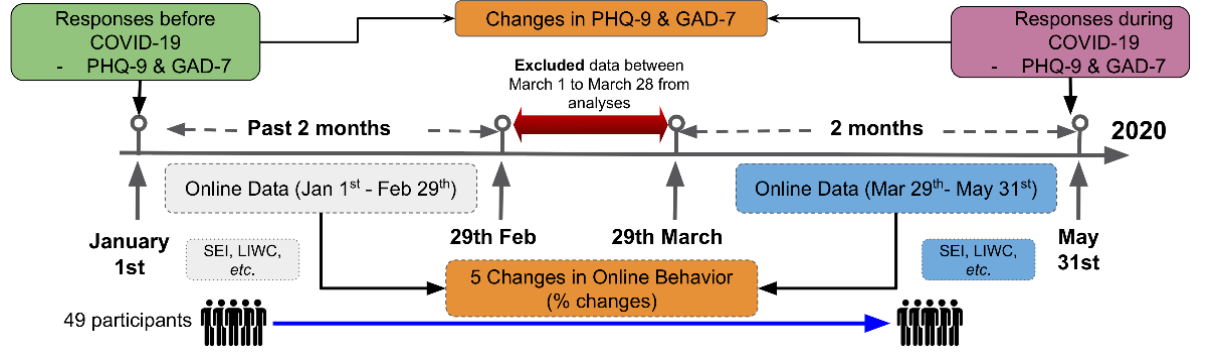
Figure 1. The study recruitment procedure and feature development process. All of the participants moved to remote learning on March 7, 2020, the same day a state of emergency was declared in New York State. To avoid any acute behavior during the transition to remote learning, we excluded the data from March 1 to 28. GAD-7: General Anxiety Disorder-7; LWIC: Linguistic Inquiry and Word Count; PHQ-9: Patient Health Questionnaire-9; SEI: short event